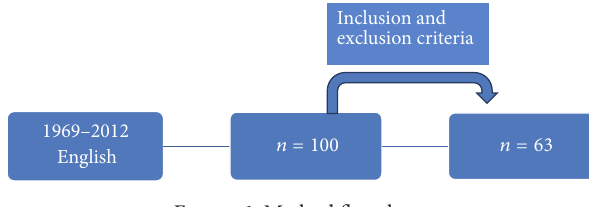
Figure 1: Method